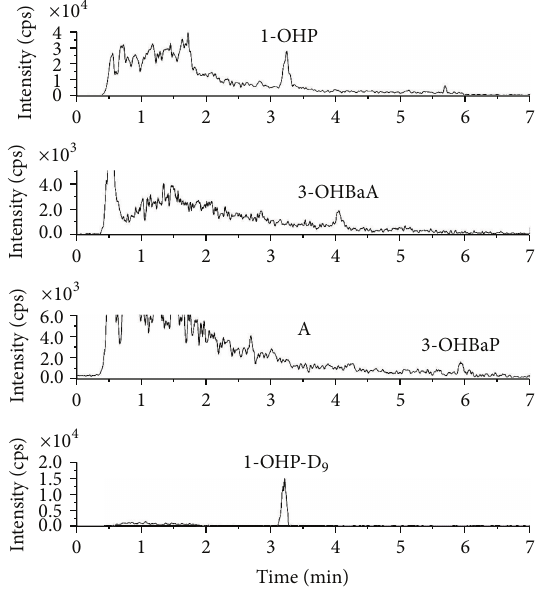
Figure 2: Representative chromatogram from a smoker.